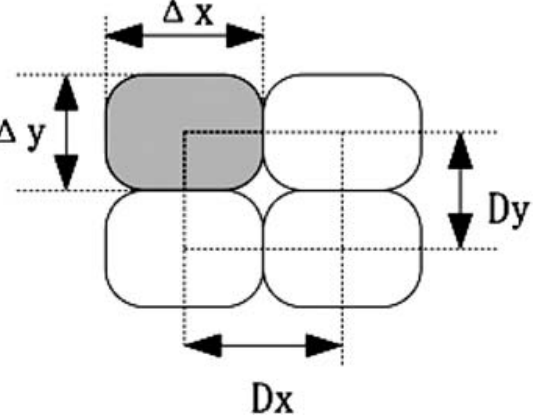
Figure 6. Representation of Gabor filtering width and Spatial Sampling.